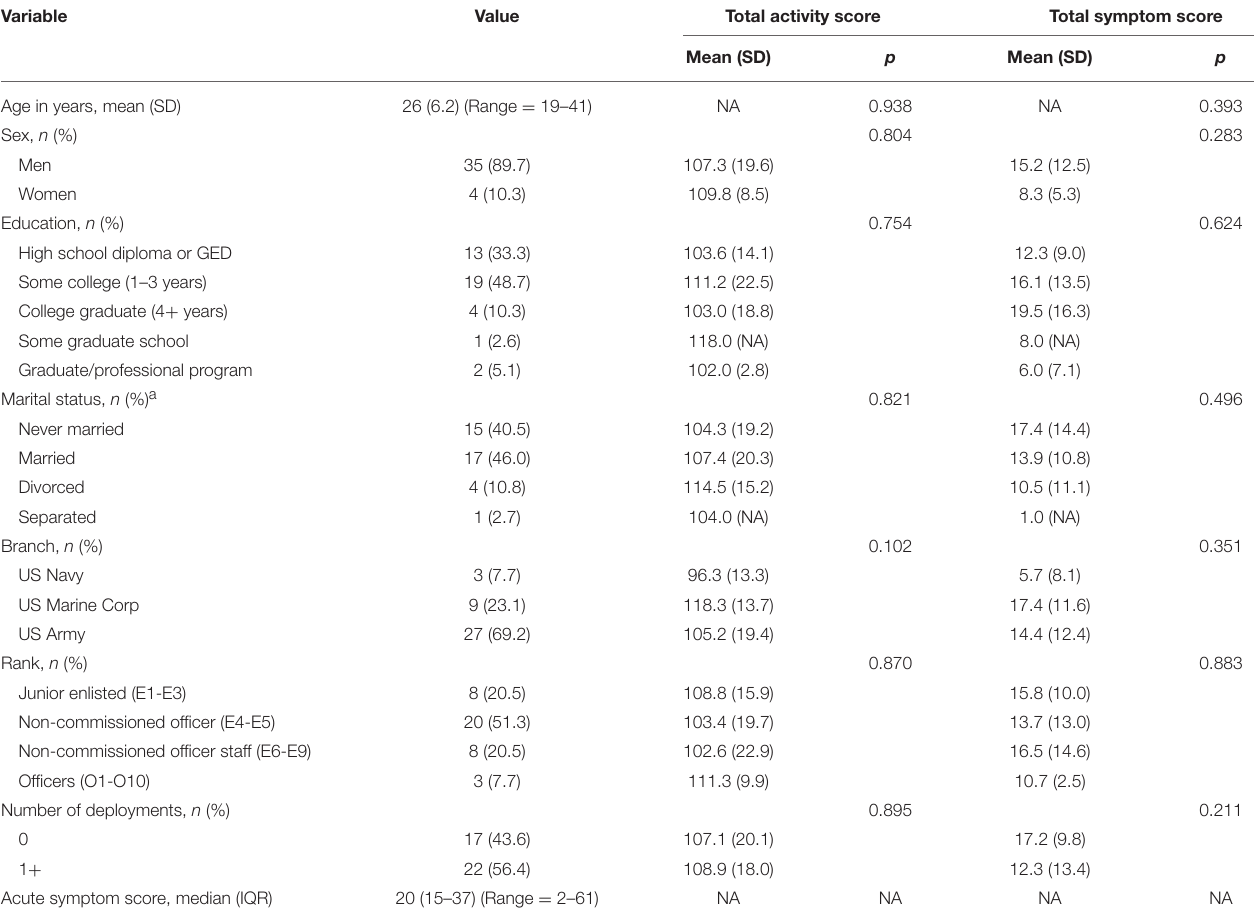
TABLE 1 | Demographic and military characteristics of service members and their relation to activity and symptom score at 3 months post-injury, overall ( n = 39).